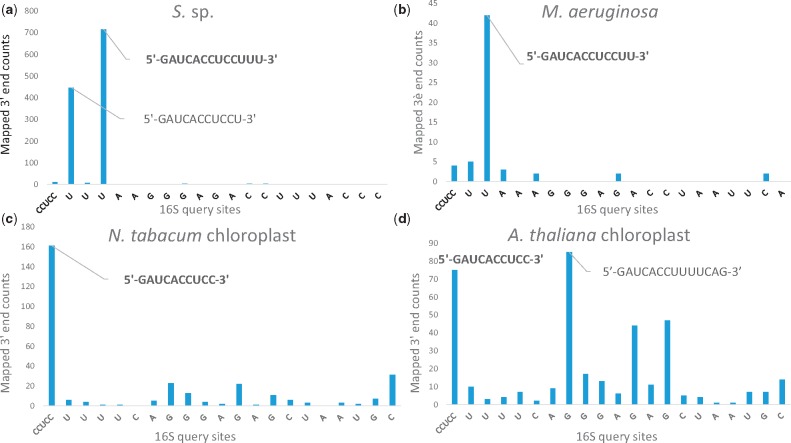
—Site-specific counts of RNA-Seq read 3′ ends mapped to the 16S rDNA query sequence in (a) S. sp., (b) M. aeruginosa, (c) N. tabacum chloroplast, and (d) A. thaliana chloroplast. The first site query is the core CCUCC motif, followed by 20 downstream sites. The identity of the most prominent 3′ tail that meets the two identification criteria is highlighted in bold.